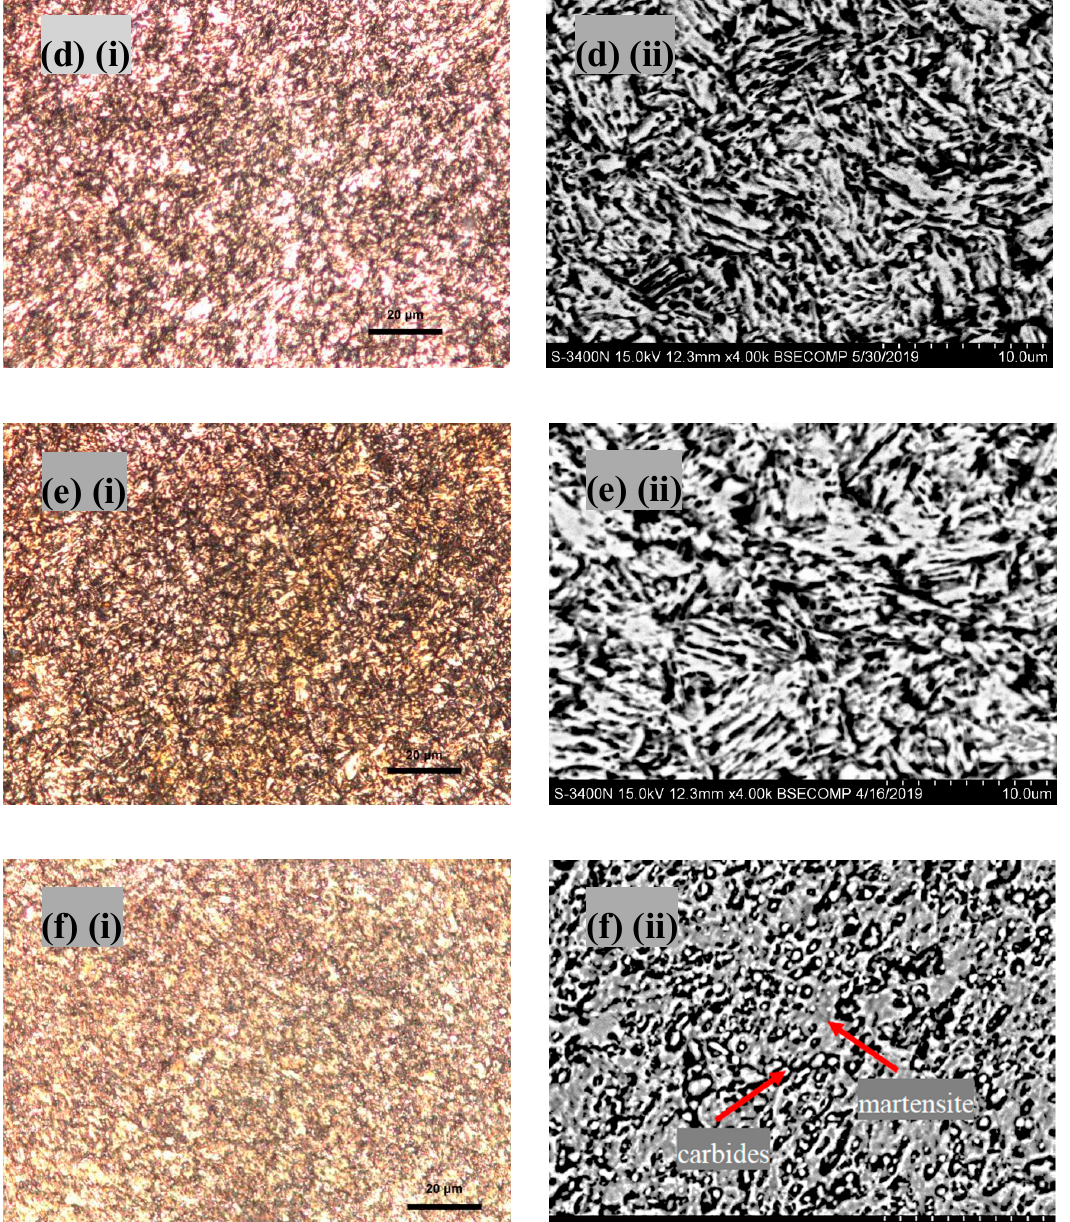
Figure 5. ( a ) Schematic diagram of cross-section of FSP75%; microstructures of ( b ) AS1, ( c ) AS2, ( d ) C1, ( e ) C2, and ( f ) RS2: ( i ) optical microscope (OM) and ( ii ) SEM micrographs.